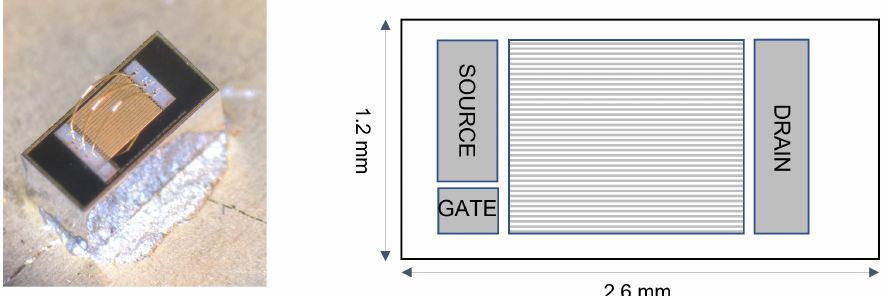
Figure 3. Picture of the bare-die GaN power switch with some test wire bonding between source and drain pads and corresponding dimensions.